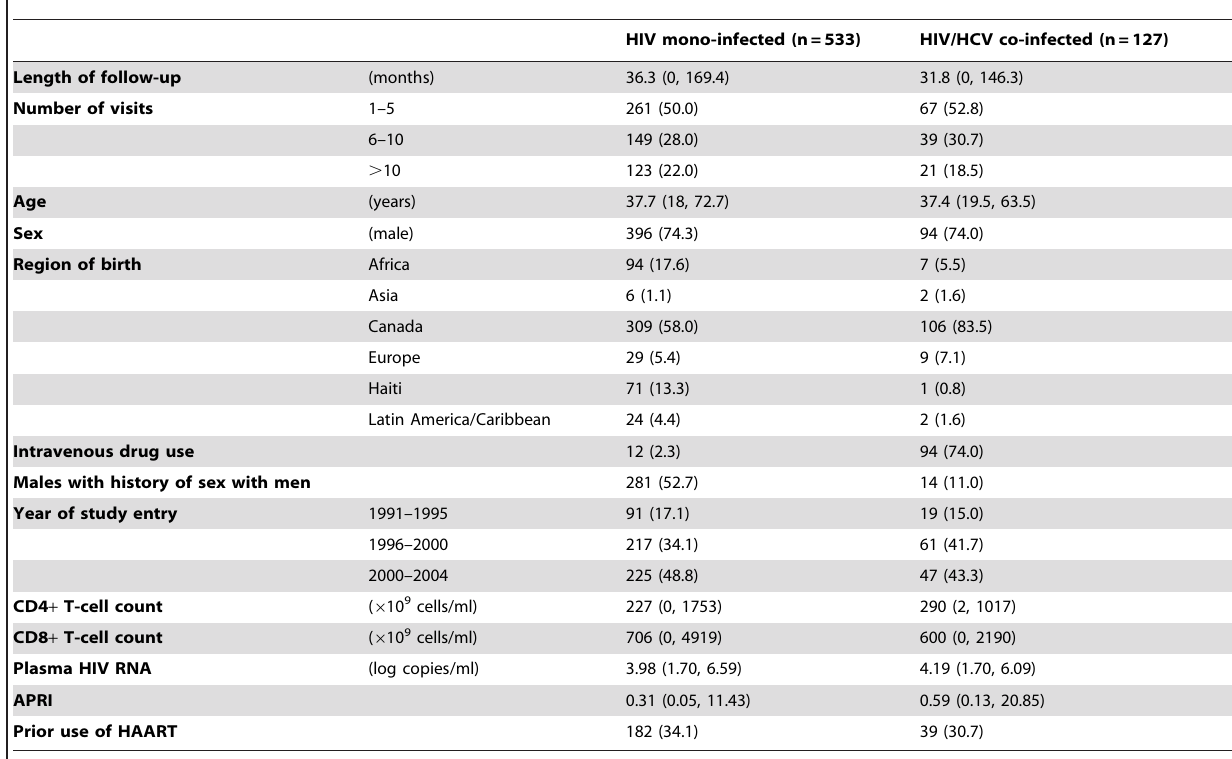
Table 1. Baseline characteristics according viral co-infection